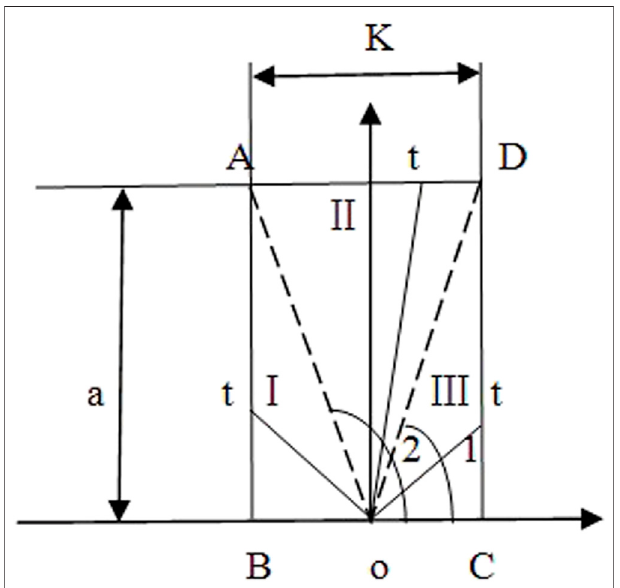
FIGURE 5 | Smart car front area in straight ahead.